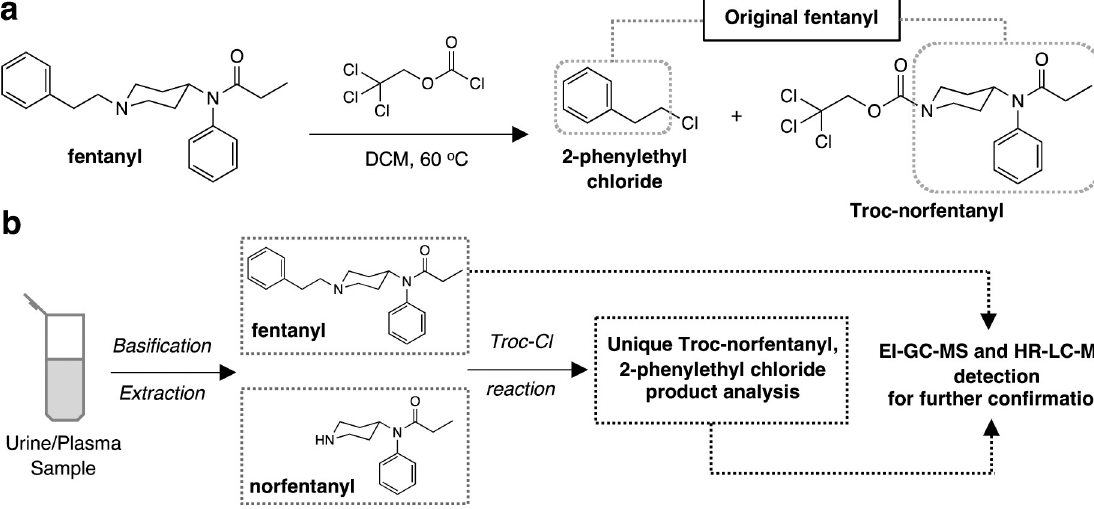
Fig 2. Chemical modification of fentanyls. (a) Reaction of fentanyl with 2,2,2-trichloroethoxycarbonyl chloride (Troc-Cl) to yield two unique, abiotic products that bear structural features of the original opioid (grayed boxes); (b) overall protocol to aid in the confirmation of fentanyl and norfentanyl in a biological sample by EI-GC-MS and targeted HR-LC-MS.